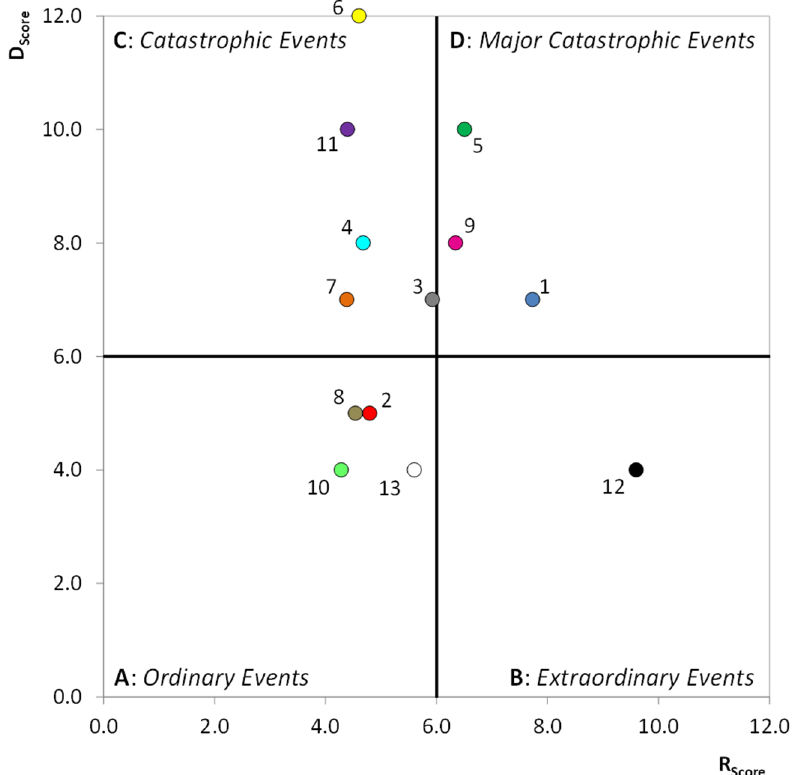
Figure 7. Chart of the severity of Calabrian DHEs. For the explanation of damage score ( D score ) and rainfall score ( R score ) see Section 2.3. Each circle represents one of the event listed in Table 1. ( A ) Ordinary events; ( B ) extraordinary events; ( C ) catastrophic events; ( D ) major catastrophic